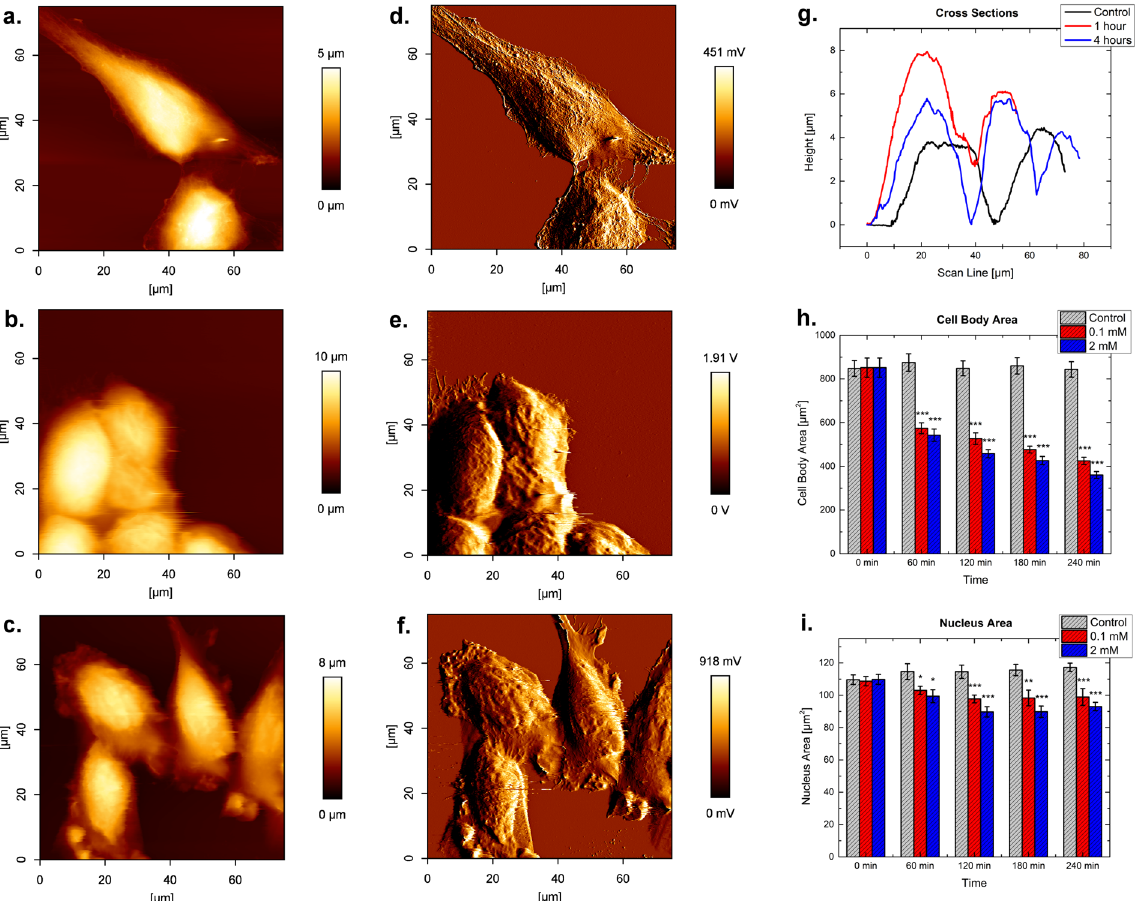
Figure 1. AFM height images in contact mode for control ( a ), cells treated for 1 hour with 2 mM Colchicine ( b ) and for 4 hours ( c ), respectively. ( d – f ) Show the corresponding error images. Cells were fixed prior to imaging. The vertical-scale is different for all images. ( g ) Shows respective cross-sections of height images for ( a – c ) with the control in black, 1 hour- incubation in red, and 4 hour-incubation in blue. ( h ) Development of the mean cell body area for the control (light grey), 0.1 mM (red) and 2 mM (blue) colchicine over the course of 240 min. ( i ) Development of the nuclear area for the control (light grey), 0.1 mM (red) and 2 mM (blue) colchicine over 240 min. Asterisks indicate the changes with statistical